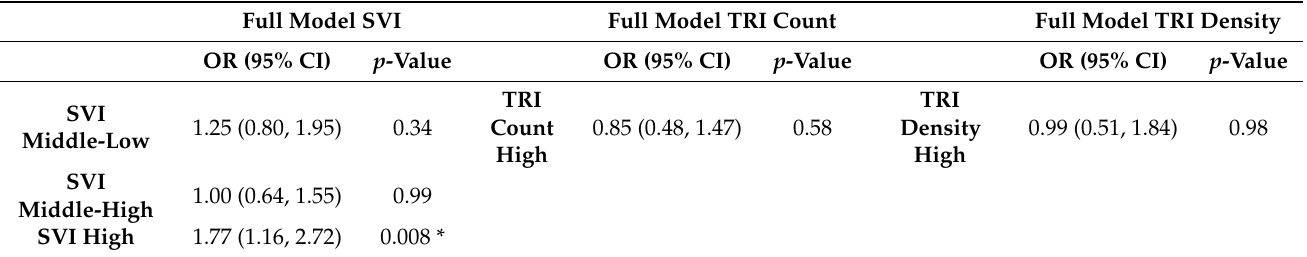
Table 2. Multivariable Models that Associate Histotype with Categorical Variables.